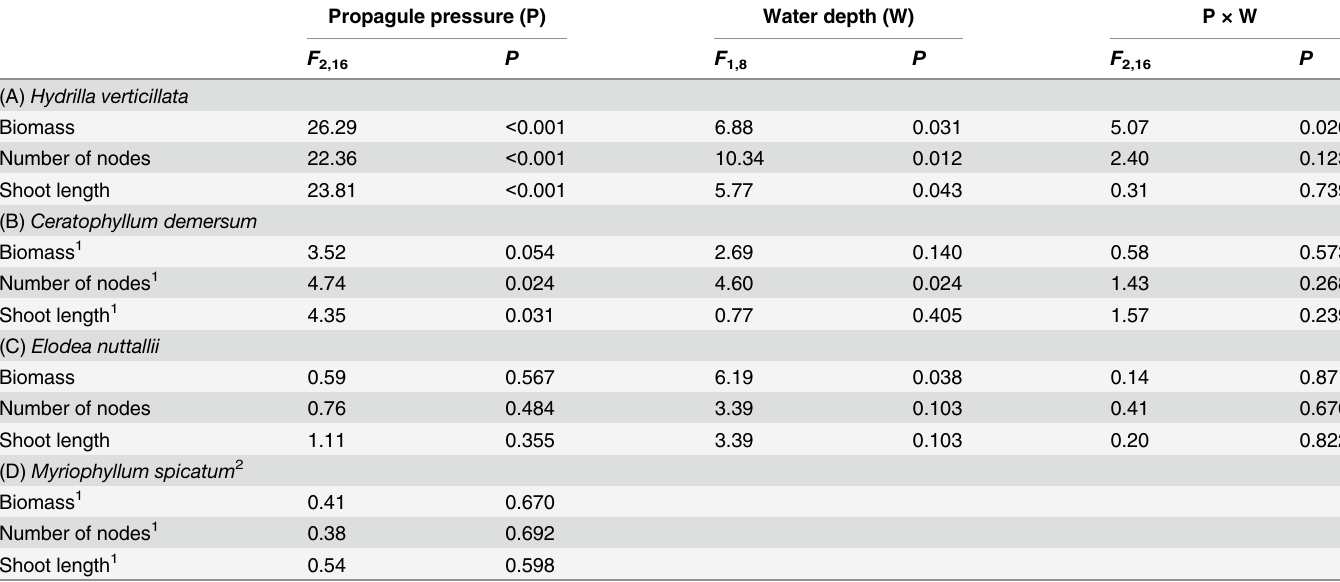
Table 2. Effects of propagule pressure and water depth on the growth of each of the four submerged macrophytes. Propagule pressure